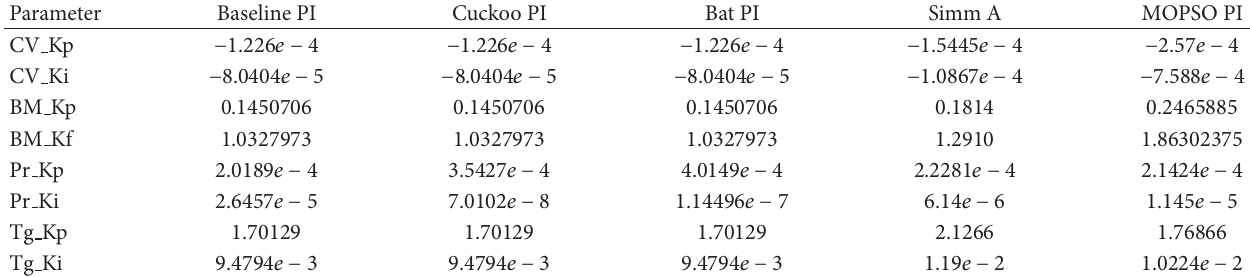
Table 5: Controller